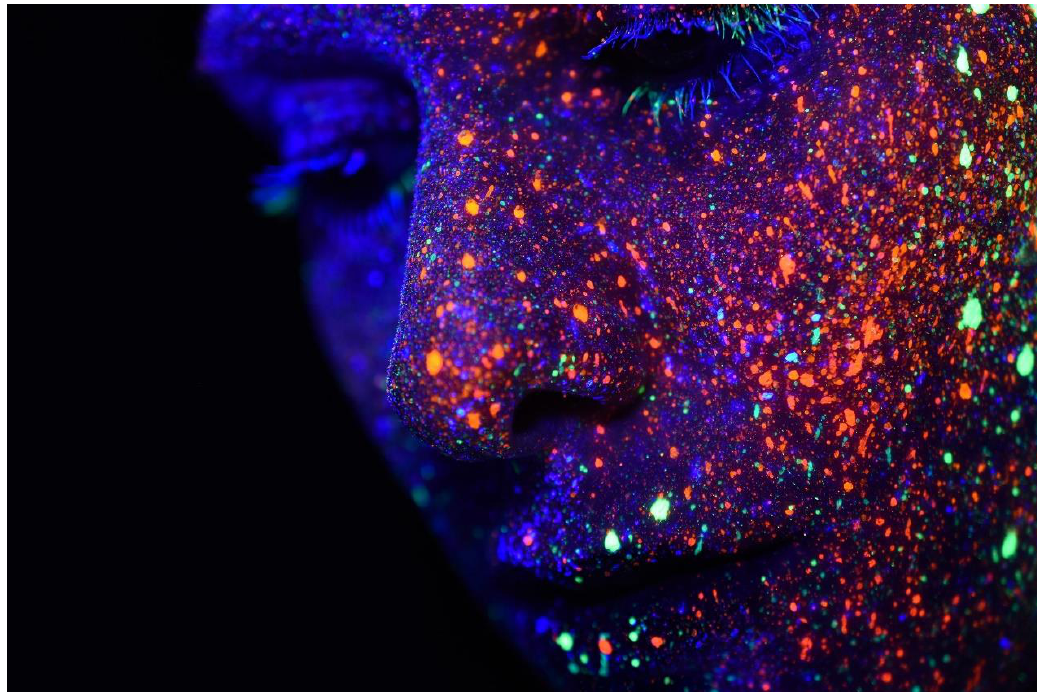
Figure 1: Photo by h heyerlein on